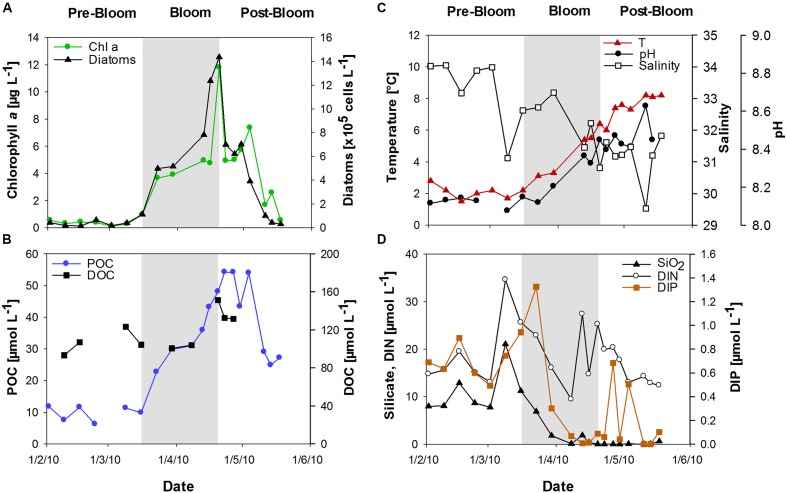
Development of the spring bloom at Helgoland Roads in 2010. (A) Chlorophyll a (Chl a) concentrations and diatom abundance, (B) Temperature, salinity and seawater pH, (C) Particulate organic carbon (POC) and dissolved organic carbon (DOC), (D) Inorganic nutrients comprising silicate (SiO2), dissolved inorganic nitrogen (DIN) and dissolved inorganic phosphorous (DIP).